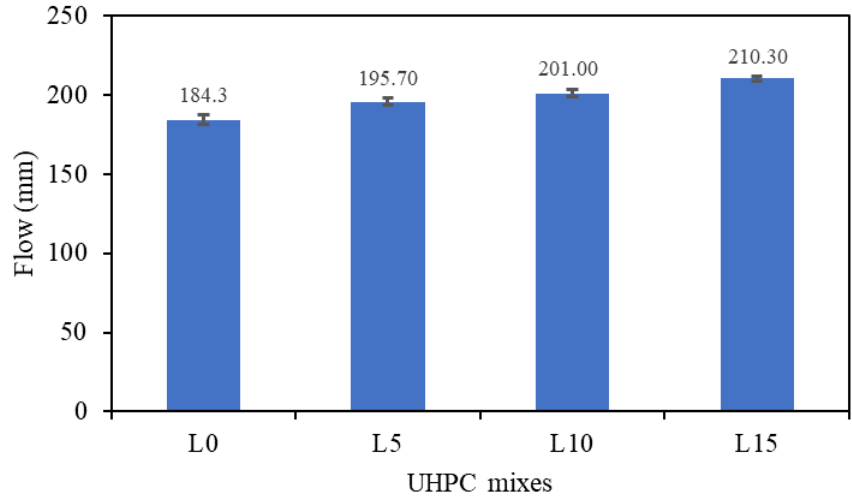
Figure 2. Flow characteristics of UHPC mixtures.